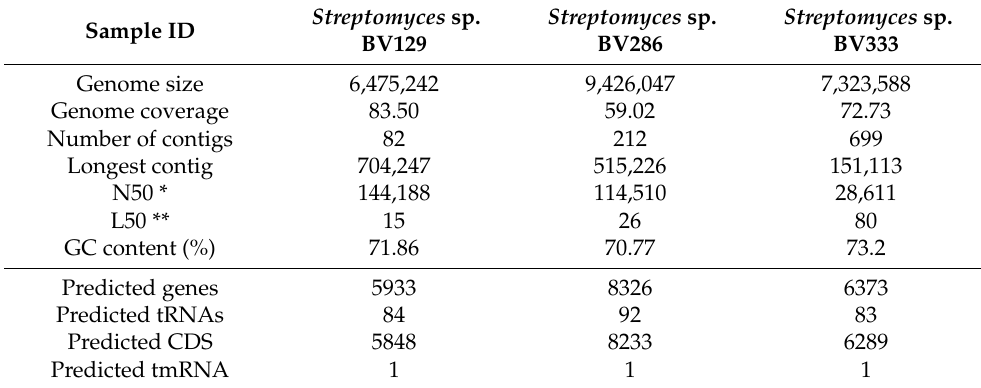
Table 1. Genome assembly statistics of Streptomyces sp. BV129, BV333 and BV286.